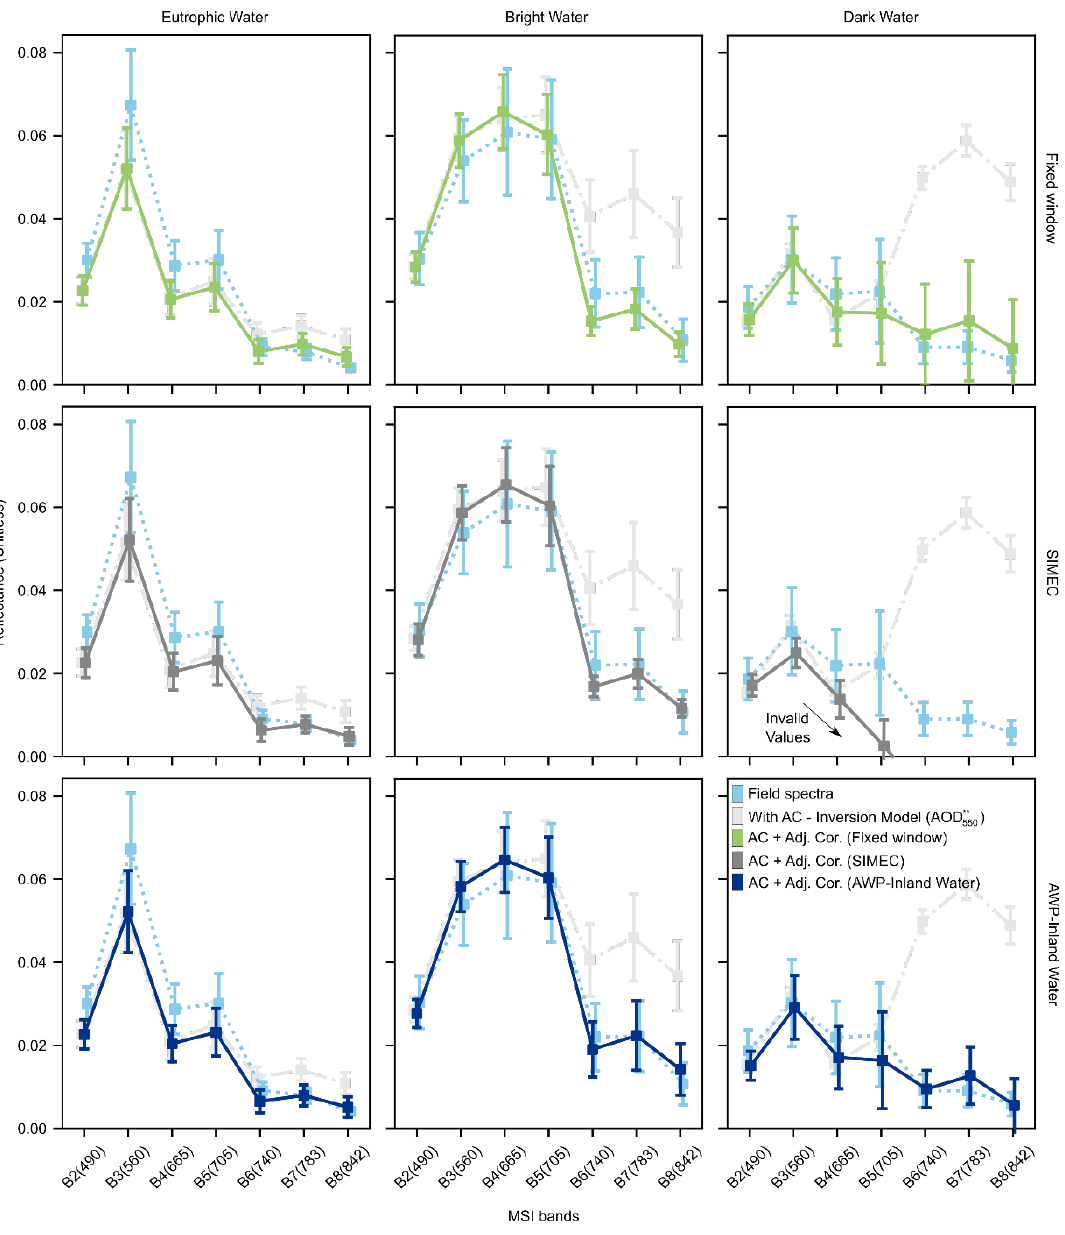
Figure 8. Differences of the water spectrum shape corrected for adjacency effects versus the field spectrum according to H Adj methods and water types.